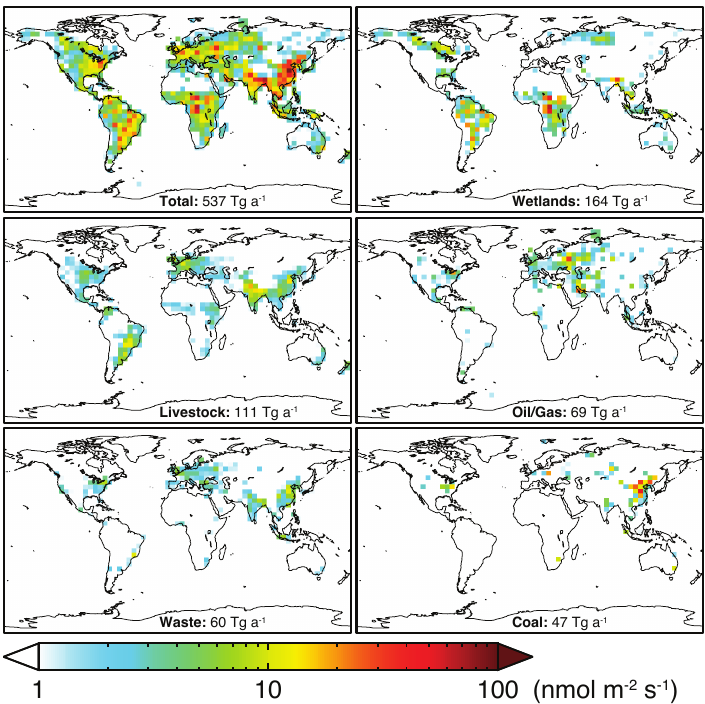
Figure A1. Prior 2009–2011 methane emissions used in the GEOS-Chem global simulation at 4 ◦ × 5 ◦ resolution, and contributions from the top five sources.